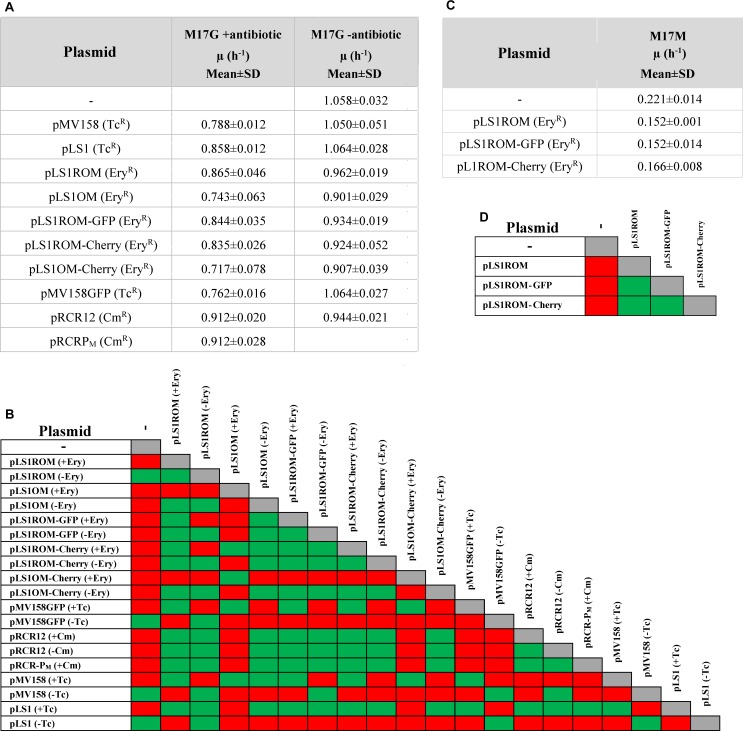
Analysis of the growth rate constant (μ) determined for any of the plasmid-containing strains. The μ values of L. lactis harboring different vectors in M17G (A) or M17M (C) are shown. In (A) the lactococcal strains were grown in the presence (+) or in the absence (−) of selective pressure for the antibiotic resistant marker codified by the resident plasmid. In (C) the plasmid-carrying strains were grown in the presence of the corresponding antibiotic. The values given in the tables of (A,C) are expressed as mean ± standard deviation (SD) of, at least, three independent experiments. A correlation matrix of the statistical significance of the growth rates of the lactococcal strains containing the studied plasmid vectors in M17G (B) or M17M (D) is displayed. Green, no statistically differences could be inferred (P > 0.05); red, statistically differences could be inferred (P < 0.05).